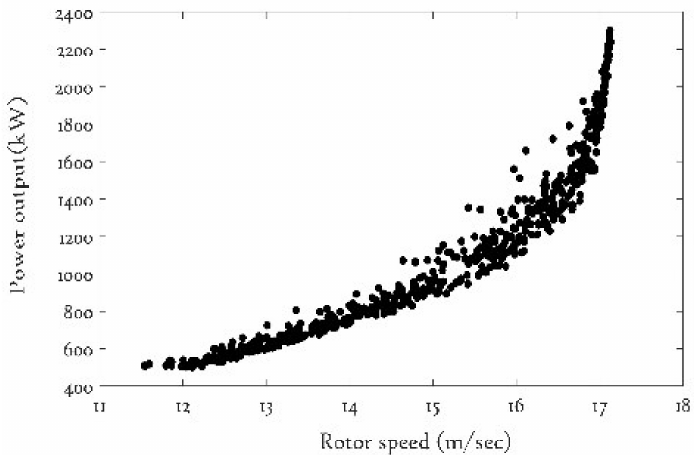
Figure 8. Filtered rotor power